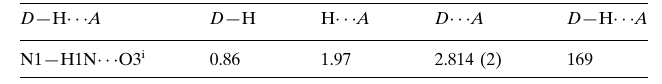
Hydrogen-bond geometry (A˚ , (cid:1)